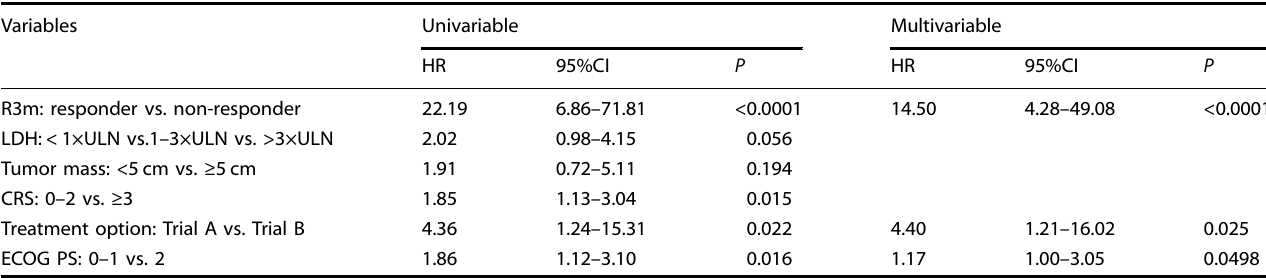
Table 2. Univariable and multivariable analysis of OS